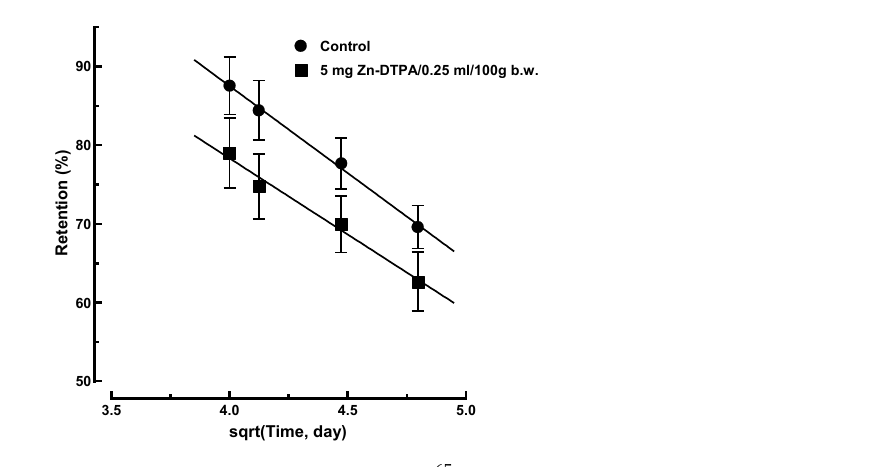
Figure 10. Square-root law modeling of 65 Zn retention following delayed intervention with Zn-DTPA for the 16 to 23 days interval compared to the control group. Data represent means ± SEM ( n = 7).